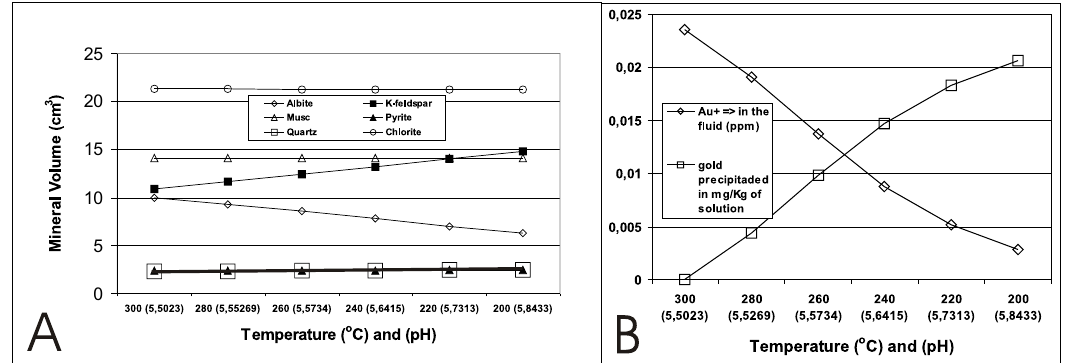
Fig. 4 – A – Volume variation of minerals reacting with thefluid due to temperature decrease. B – Relation of Au+ in thefluid (ppm) vs. gold precipitated (mg/Kg of solution) due to temperature decrease.